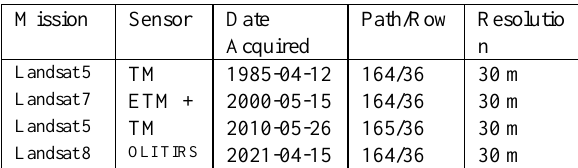
Table 1 . Details of satellite data used in the